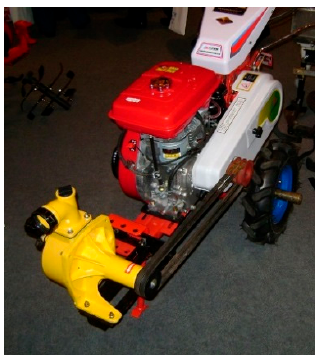
applying the mulching film, (Photo: Brian Sims).